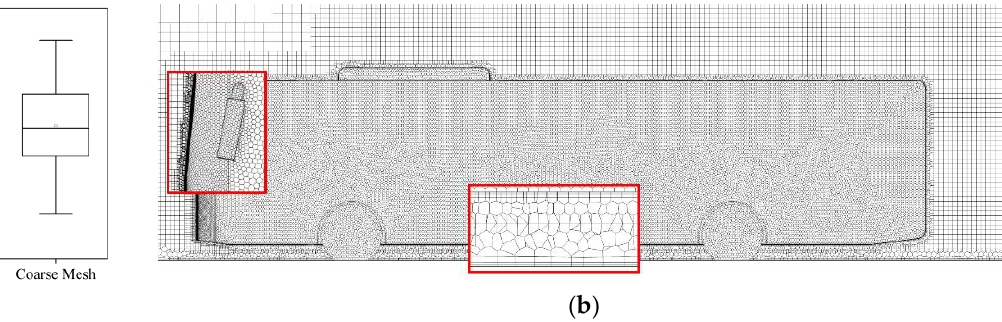
Figure 4. ( a ) Mesh sensitivity results and ( b ) vertical cross-section view of the Medium Mesh.